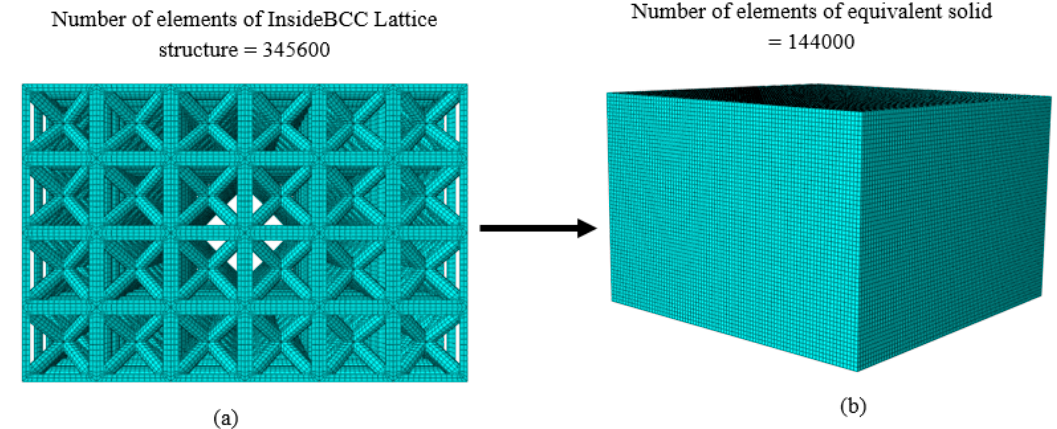
Figure 8. FEA mesh of full simulation for ( a ) the InsideBCC lattice cell structure (LCS) model and ( b ) the equivalent solid model.